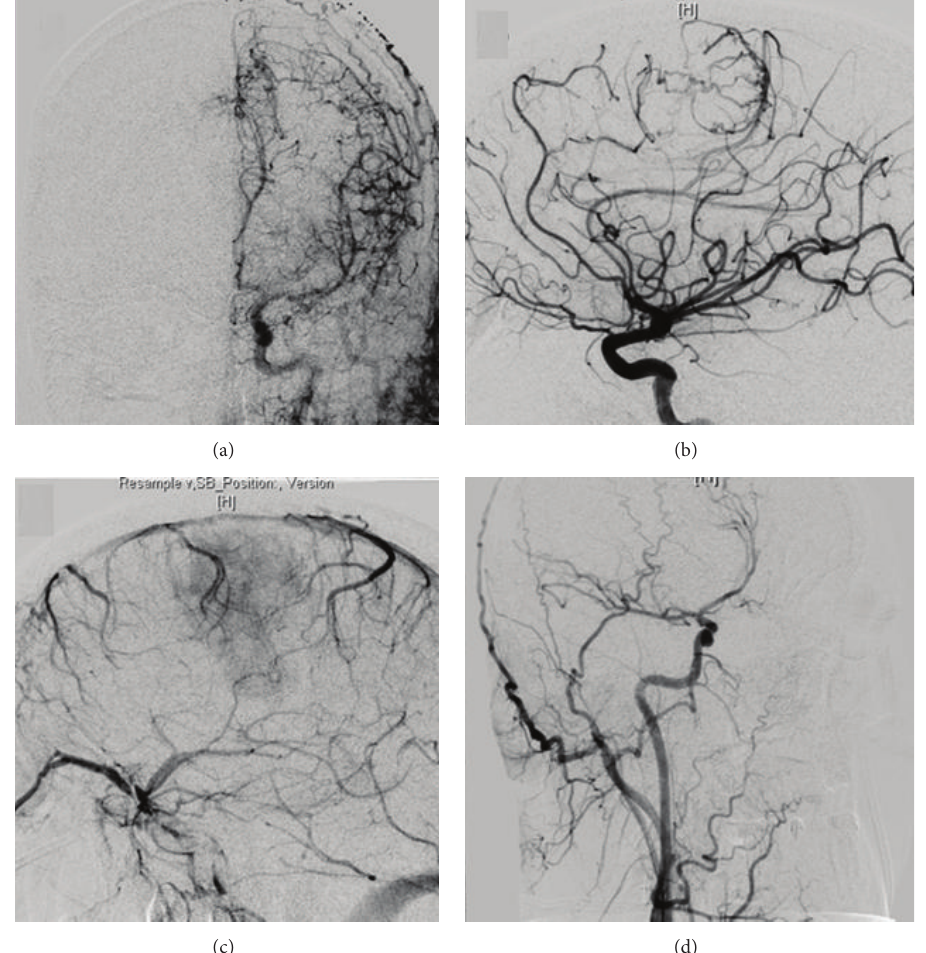
Figure 2: Cerebral angiogram in (a) AP and (b) lateral common carotid injections demonstrating blood supply of the tumor crossing midline from the left distal ACA. The left carotid venous phase (c) shows a dense tumor blush. An oblique right common carotid injection (d) demonstrates no contribution to the